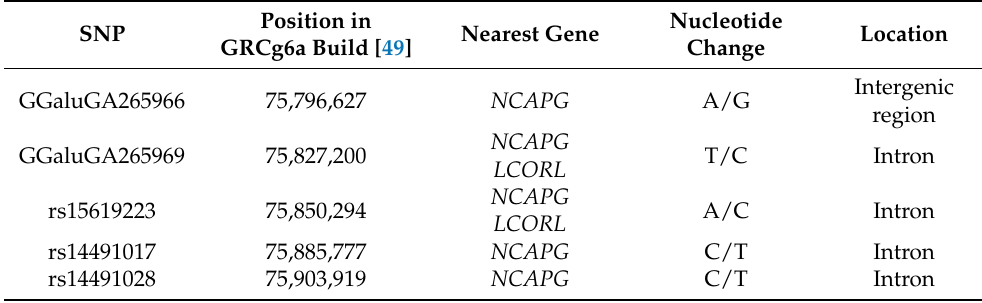
Table 1. Summary for the five SNPs at the NCAPG-LCORL locus on